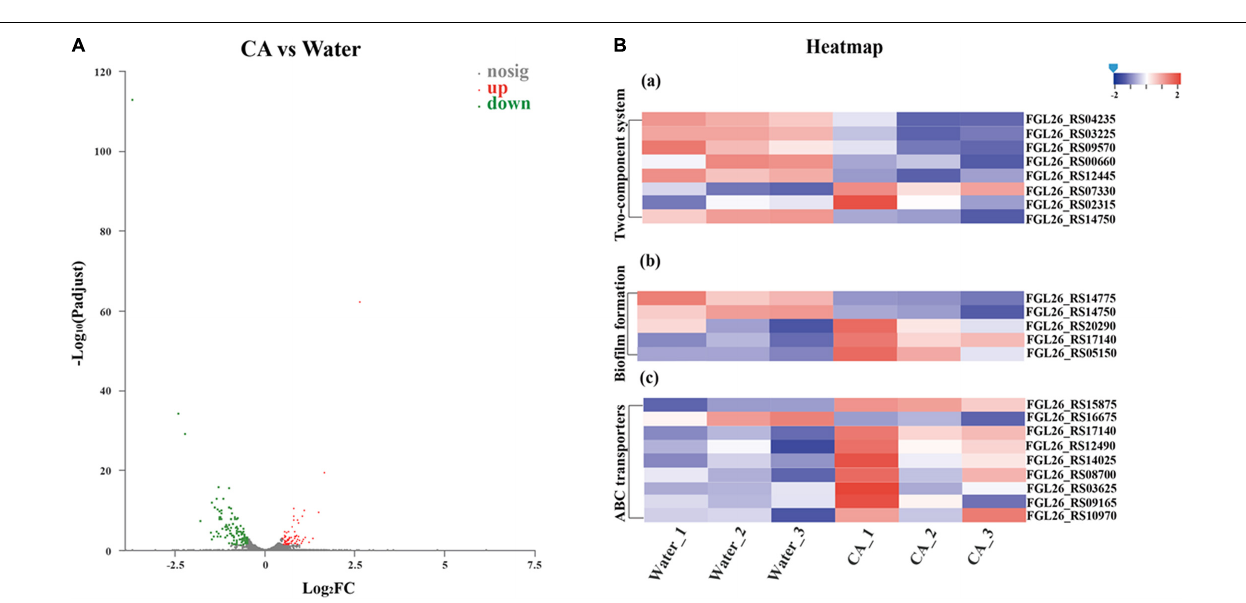
FIGURE 7 | Transcriptome analysis of Y. enterocolitica after treatment with CA. (A) Volcano plot of expression of genes in Y. enterocolitica after treatment with CA. (B) Analysis of DEGs in Y. enterocolitica after treatment with CA. (a) Two-component system. (b) Biofilm formation. (c) ABC